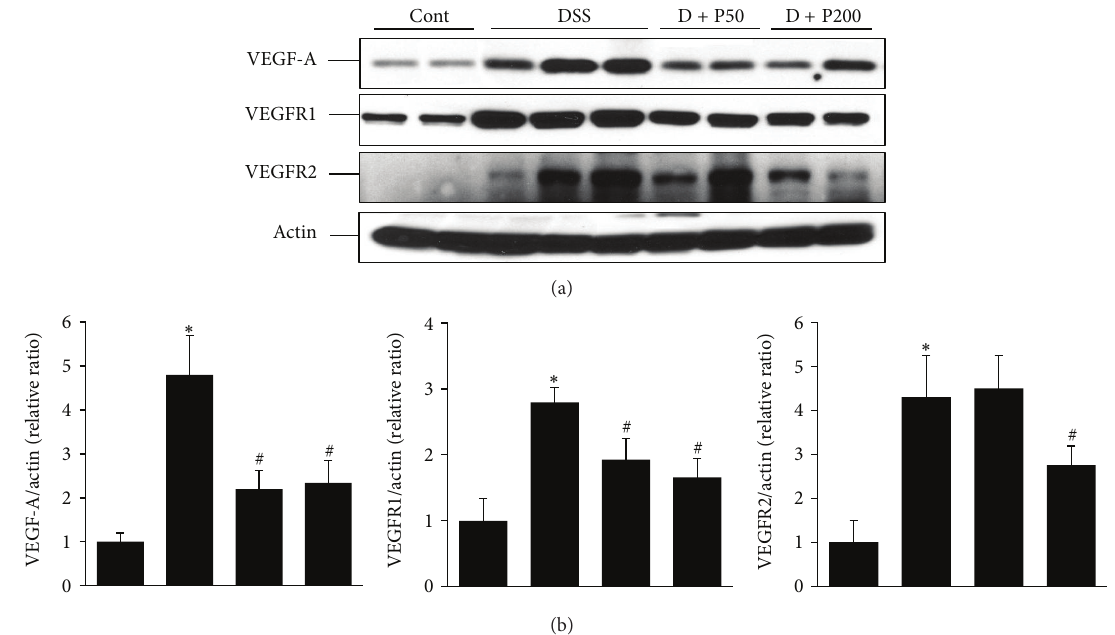
Figure 4: Expression of VEGF-A and VEGFR2 in a 𝛾 -PGA-treated DSS-induced colitis model. (a) VDGF-A and VEGFR2 expression levels were determined by immunoblotting in colon samples from the control group (without DSS; Cont), 3% DSS administration group (DSS), 3% DSS with 𝛾 -PGA at 50mg/kg body weight per day (D + P50), 3% DSS with 𝛾 -PGA at 200mg/kg body weight per day (D + P200). 𝛽 -Actin was used as an internal control. (b) Densitometric analyses are presented as the relative ratio of each protein to actin. The ratio relative to the control is arbitrarily presented as 1. Bars represent the mean ± SD from 3 experiments. ∗ 𝑃 < 0.05 versus control; # 𝑃 < 0.05 versus DSS.